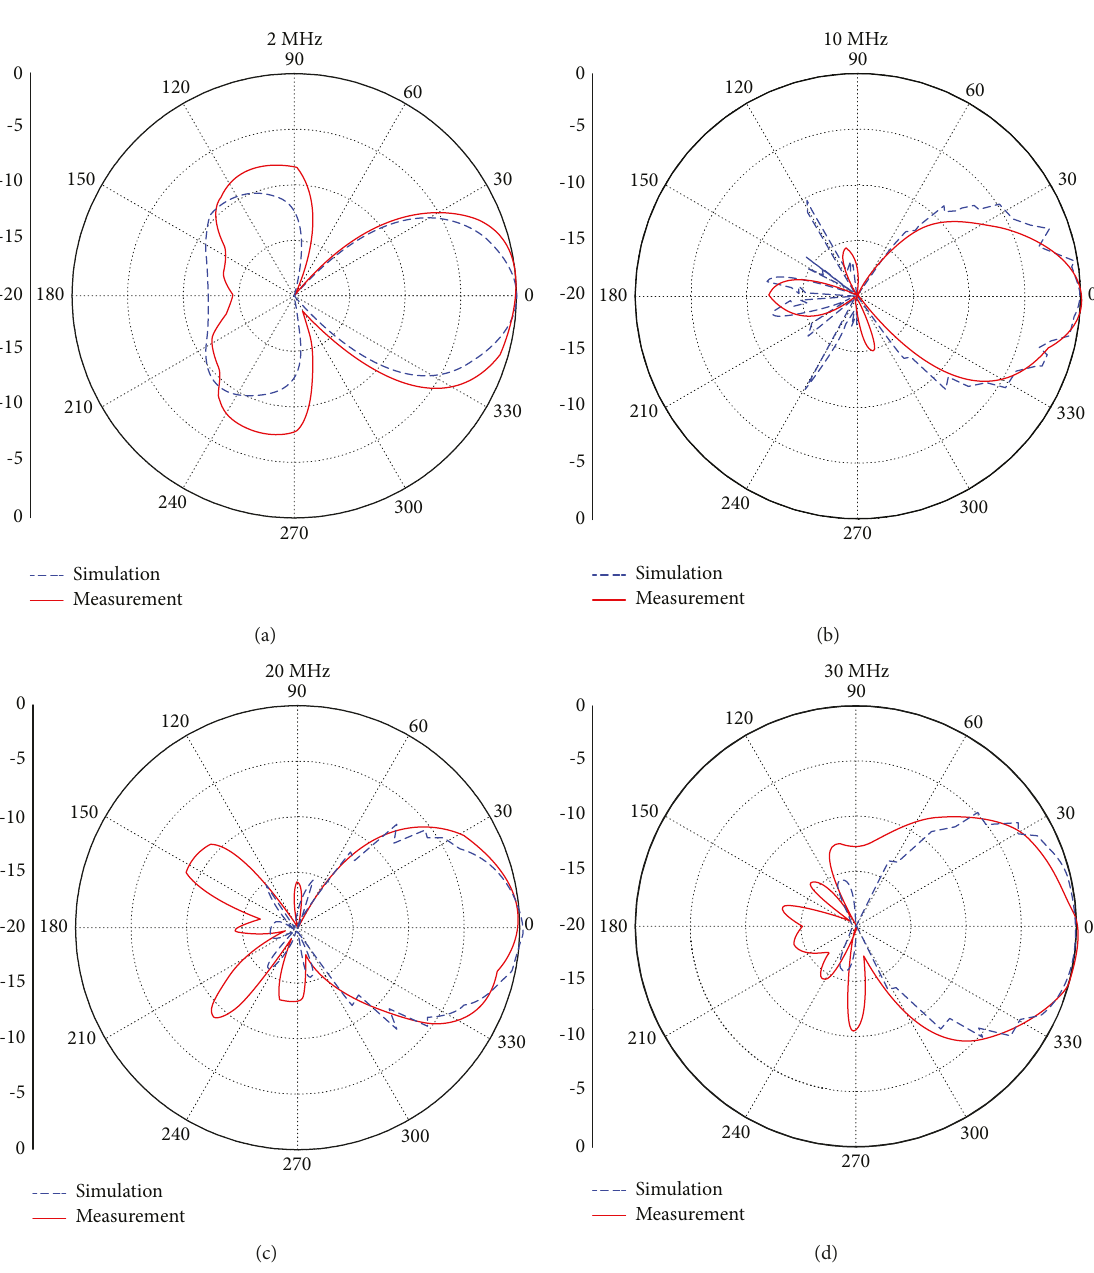
Figure 13: The measured horizontal pattern with the elevation angle of 8